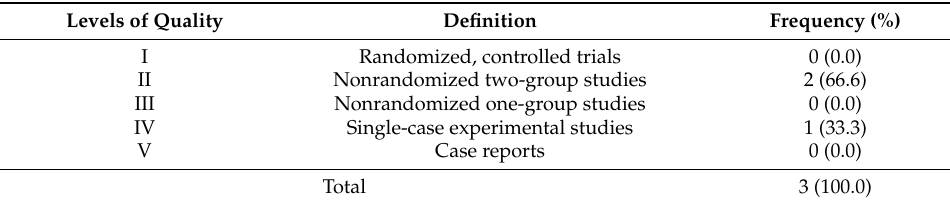
Table 1. Number of Selected Articles by Level of Evidence.